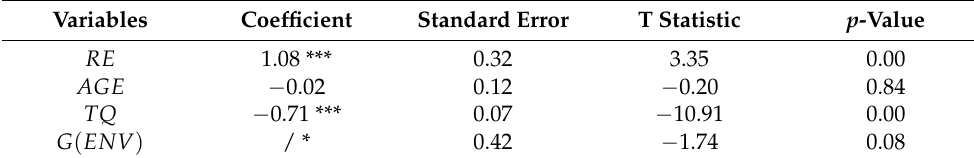
Table 5. Impact of environmental policies on renewable energy development.